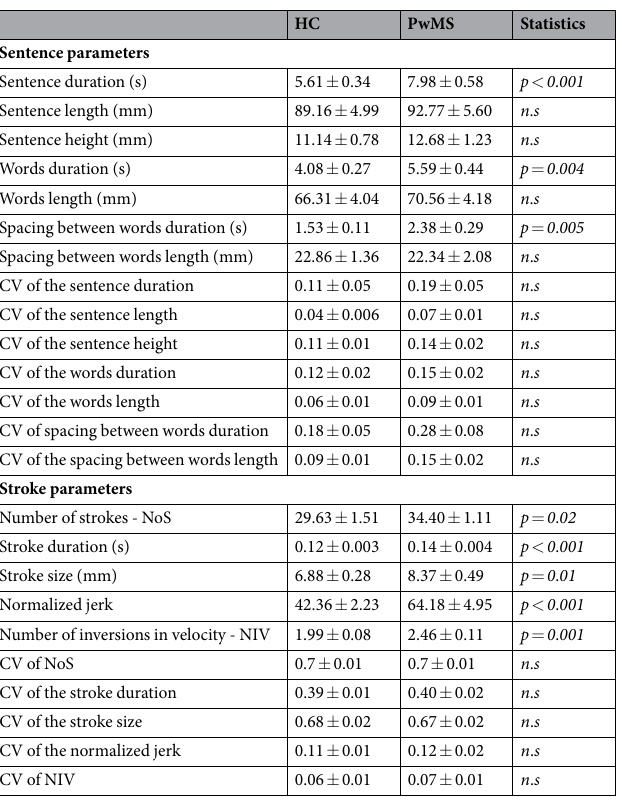
Table 1. Kinematic measurements of the sentence and of the strokes. Data are reported as mean ± standard error. No significant differences between healthy controls (HC) and people with multiple sclerosis (PwMS) are marked as